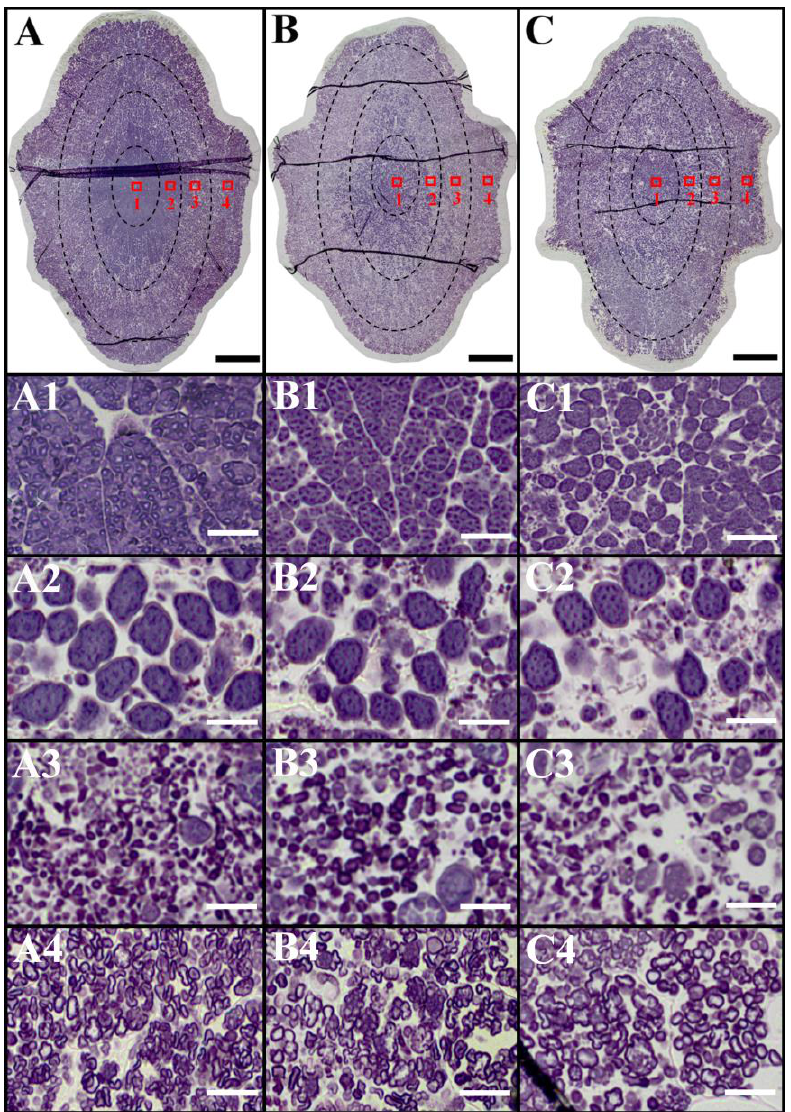
Figure 4. Morphology of starch granules in non-shrunken ( A ), slightly shrunken ( B ), and moderately shrunken seeds ( C ). The whole seed was transversely sectioned at the mid-region of the seed. ( A1 – A4 ), ( B1 – B4 ), and ( C1 – C4 ) are magnified regions responsible for the square areas in ( A ), ( B ), and ( C ), respectively. Scale bar = 300 μm for ( A – C ) and 20 μm for ( A1 – C4 ).